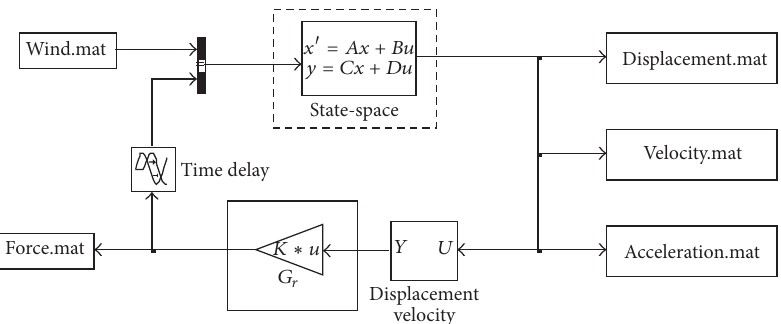
Figure 1: Simulink block diagram of the reduced-order controller with GCC algorithm.